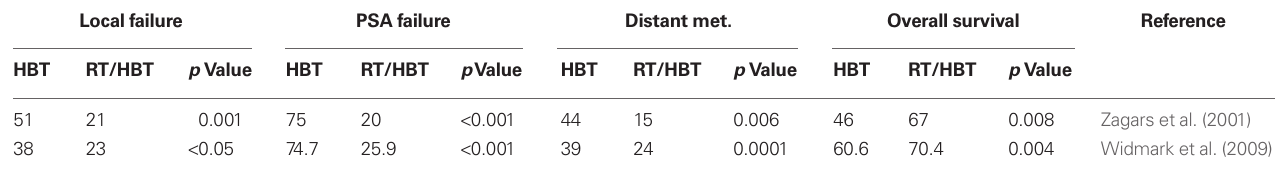
Table 3 | Comparison of treatment outcomes of HBT and HBT/RT (percentage). Local failure PSA failure Distant met. Overall survival